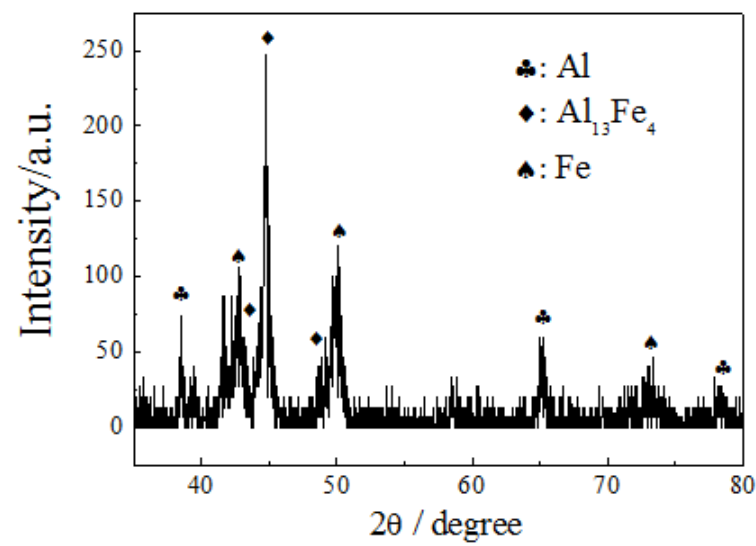
Figure 6. XRD of the PMEDA machined surface with 12A peak current.